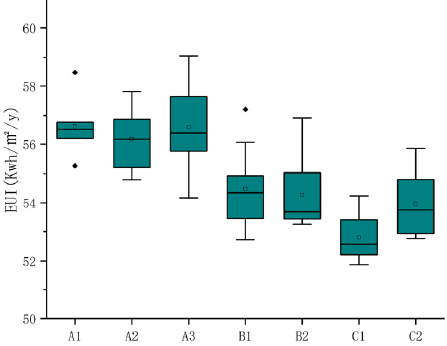
Figure 16. Distribution characteristics of total EUI in different typologies of office blocks.